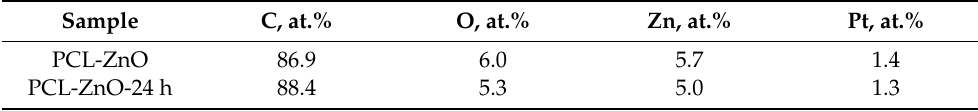
Table 2. Sample atomic compositions measured by